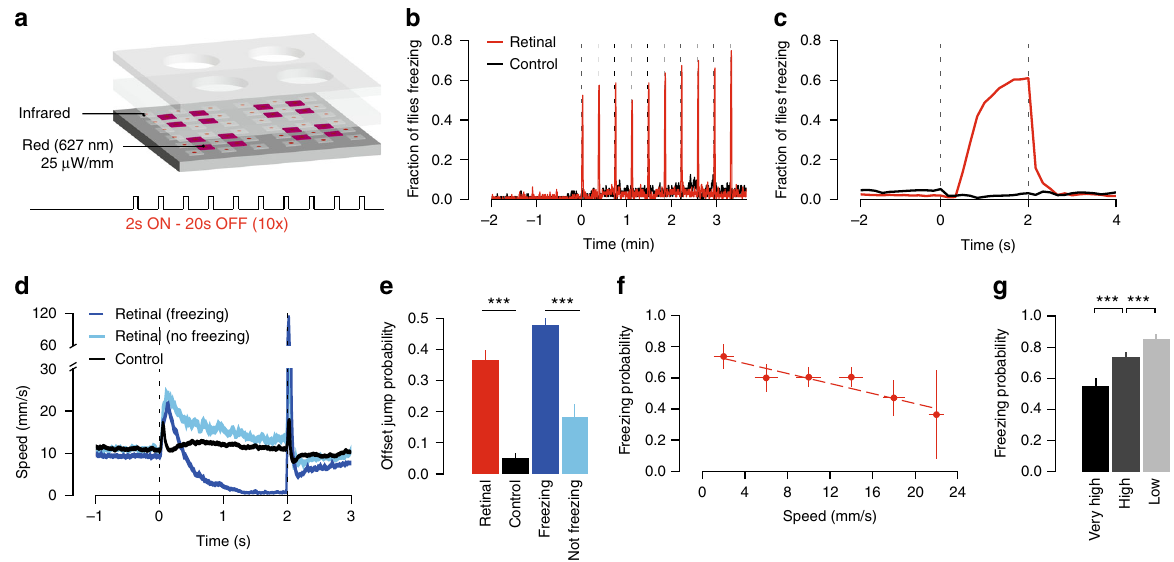
Fig. 6 Activation of DNp09 descending neurons leads to freezing. a Schematic of experimental set-up for CsChrimson stimulation and stimulation protocol. Test fl ies supplemented with retinal ( n = 80) and control fl ies raised in normal food ( n = 72). b Fraction of fl ies freezing. Dashed lines indicate light stimulation. c Fraction of fl ies freezing aligned on light activation (retinal n = 800, control n = 720 stimulation events). d Stimulus-triggered speed pro fi le (average ± s.e.m.) aligned on light presentation for stimulations that induced freezing (dark blue, n = 492), stimulations that did not (light blue, n = 308) and control (black, n = 720). e Probability ( + 95% CI) of jumping at light offset for control and test fl ies (black and red bars). Probability of jumping at light offset for stimulation events of test fl ies that induced freezing and events that did not (dark and light blue bars). f Probability of freezing to red light stimulation as a function of pre-stimulation speed ( r 2 = 0.87, p = 0.007). X-error bars show s.d. for speed sampled within each interval and Y-error bars show 95% CI. g Probability of freezing for DNp09 > CsChrimson fl ies ( n = 50 for each condition) tested at different speeds (number of stimulation events for very high, high and low were 403, 674 and 593, respectively). *** denotes p <